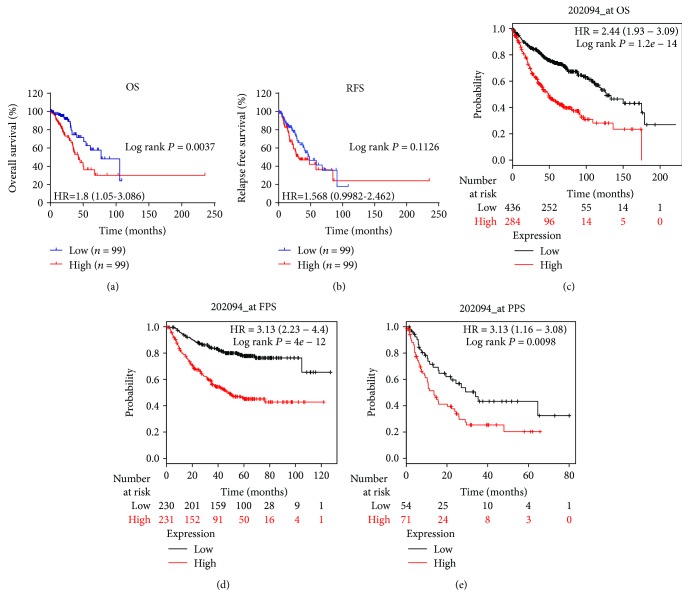
Associations between BIRC5 and survival times. OS (a) and RFS (b) in triple-negative (TN) lung adenocarcinomas based on TCGA database. OS (c), FPS (d), and PPS (e) in lung adenocarcinomas (LAD) based on the Kaplan-Meier plotter database. The red lines represent patients with high BIRC5 expression, and the blue and black lines represent patients with a low BIRC5 expression.